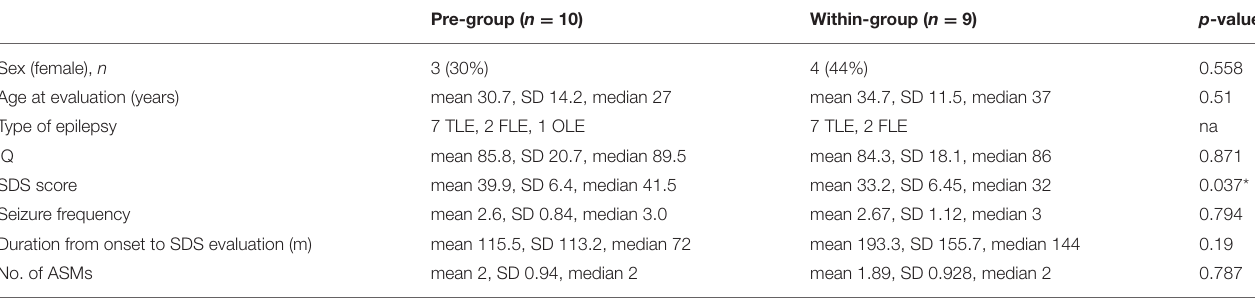
TABLE 1 | Clinical information and SDS scores.